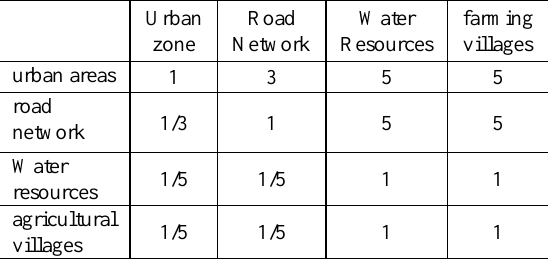
Table 2. Matrix weighting pairwise criteria.